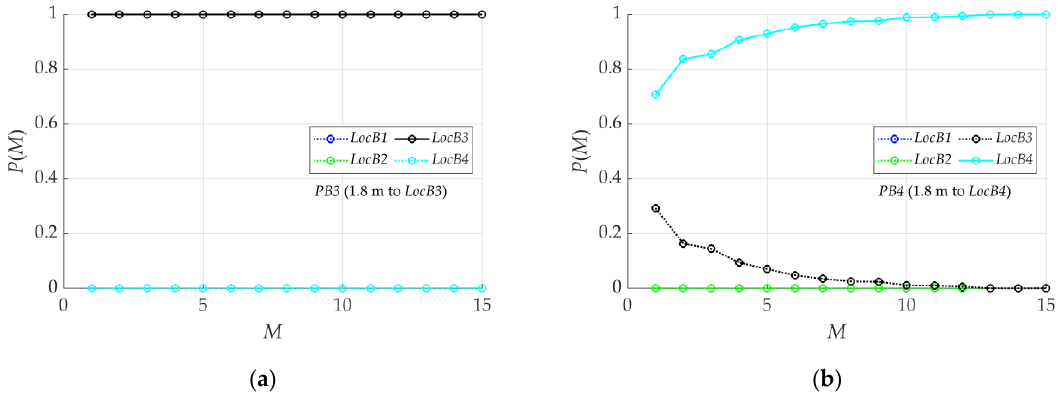
Figure 19. Probability of detecting each of the locator nodes depending on the width M of the moving window for an object located at a distance of 1.8 m from the receiver: ( a ) LocB1 (location PB1 ); ( b ) LocB2 (location PB2 ).